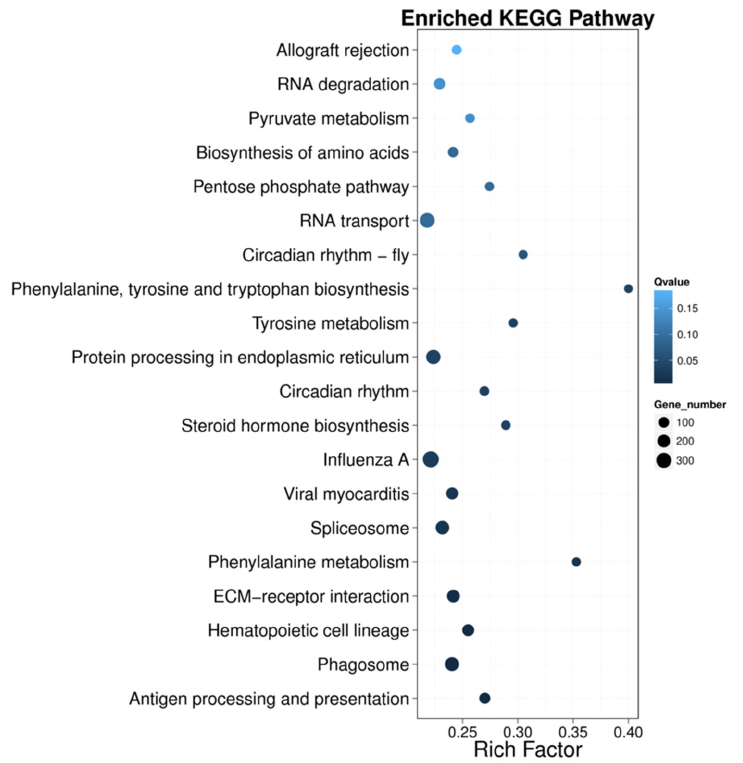
Figure 4. The DEG-enriched KEGG pathway scatter plot in the heat stress regulation of rainbow trout. The X -axis represents the enrichment factor, and the Y -axis represents the pathway; color represents p -value, and dot size represents the number of genes.